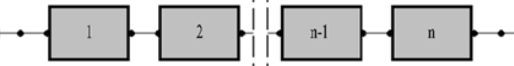
Figure 2: The n- members parallel